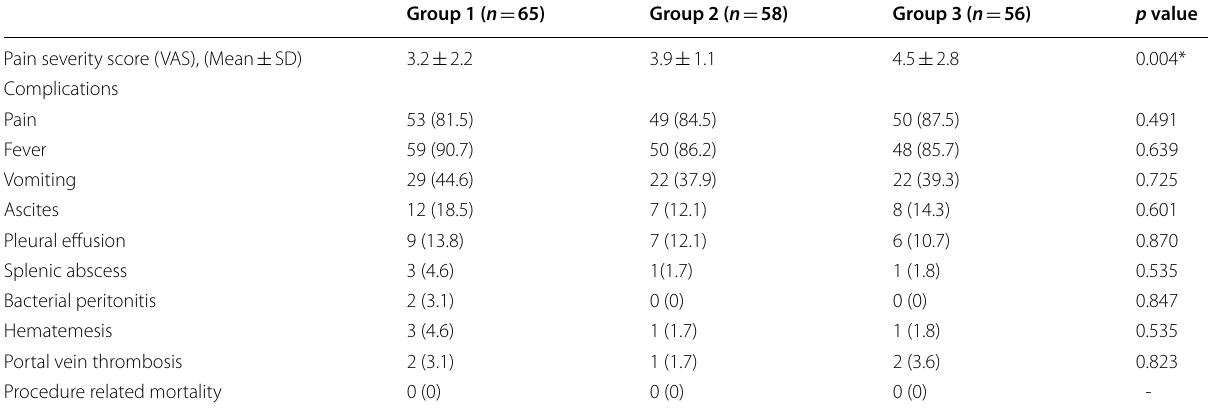
Unless otherwise indicated, data represent the number of patients and percentage in parenthesis